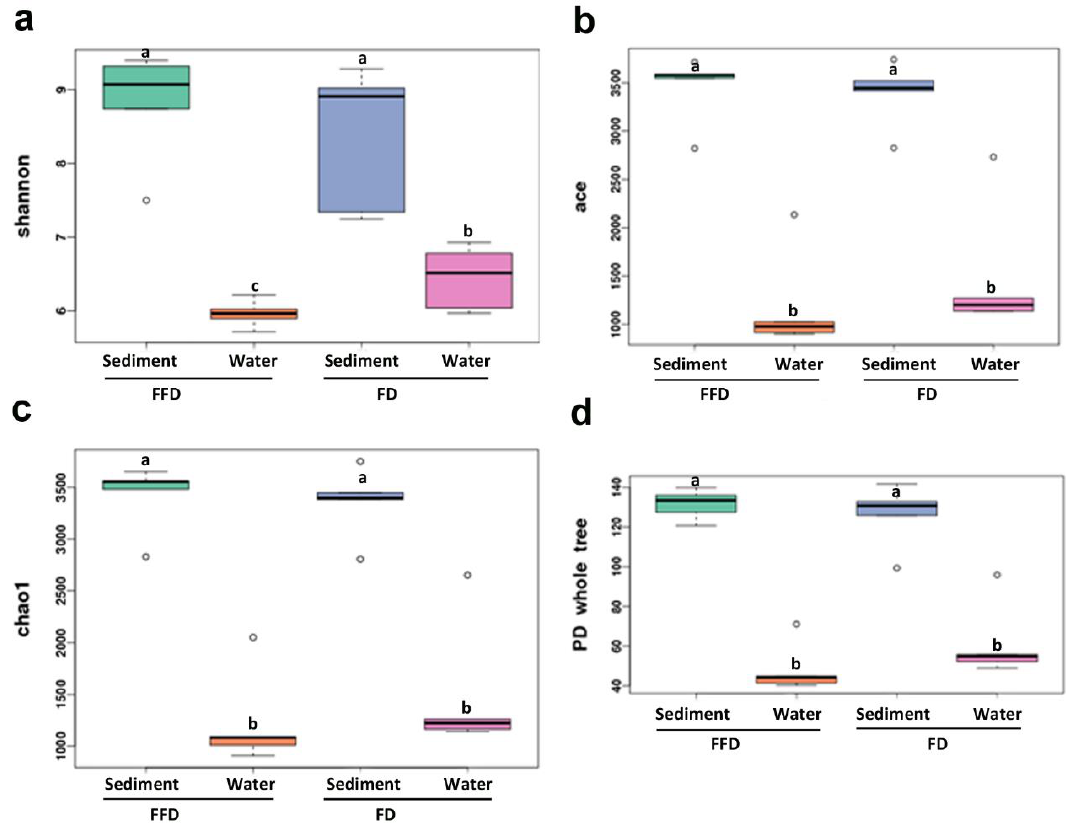
Figure 1. The alpha diversity (( a ) Shannon; ( b ) ace; ( c ) chao1; ( d ) phylogenetic diversity (PD) whole tree) of sediment and water samples from both fresh frozen diet (FFD) and formulated diet (FD) treatments. The bar with different letters indicates significant difference ( p < 0.05).